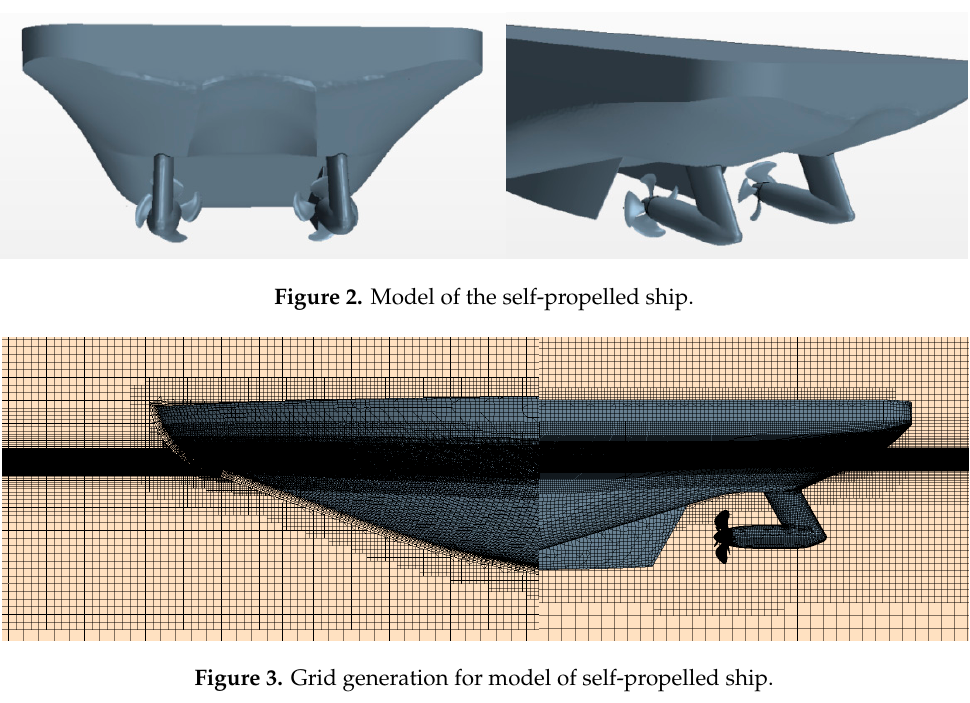
Figure 3. Grid generation for model of self-propelled ship.